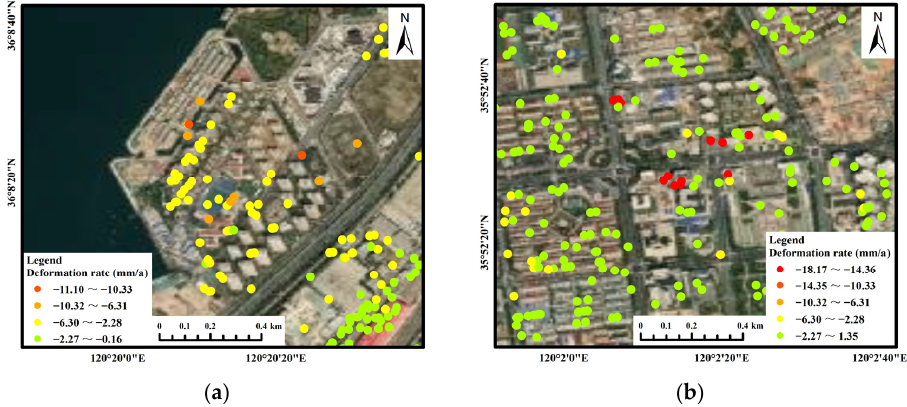
Figure 15. Deformation rates in Areas C and E: ( a ) Area C; and ( b ) Area E.